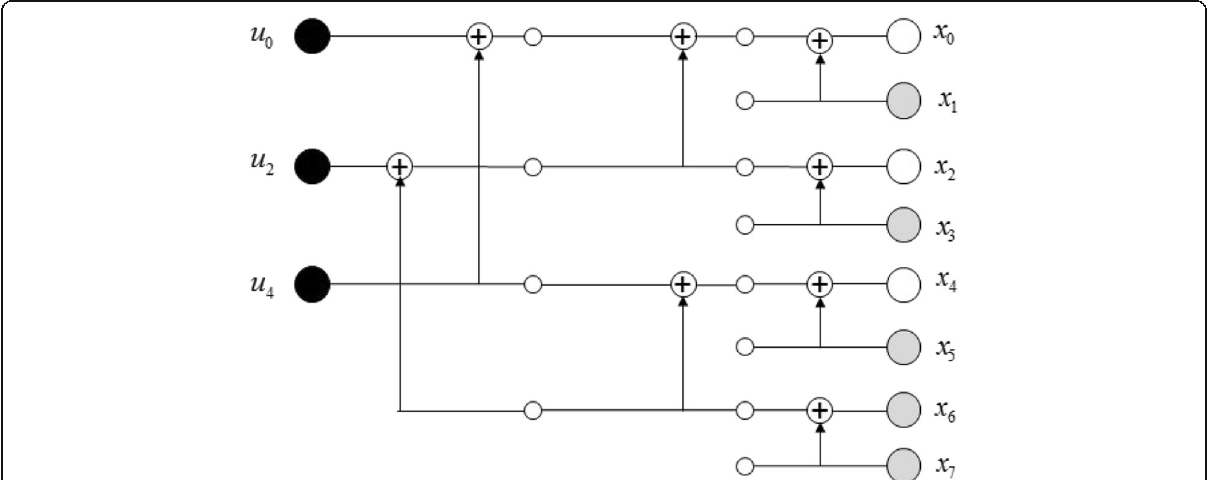
Fig. 2 Our SPC encoding optimization algorithm diagram: The gray nodes on the rightmost represent the information bits, and the black nodes on the leftmost represent the frozen bits. The right black nodes are unknown and the outputs of the SPC encoder are to obtain x 0 , x 2, and x